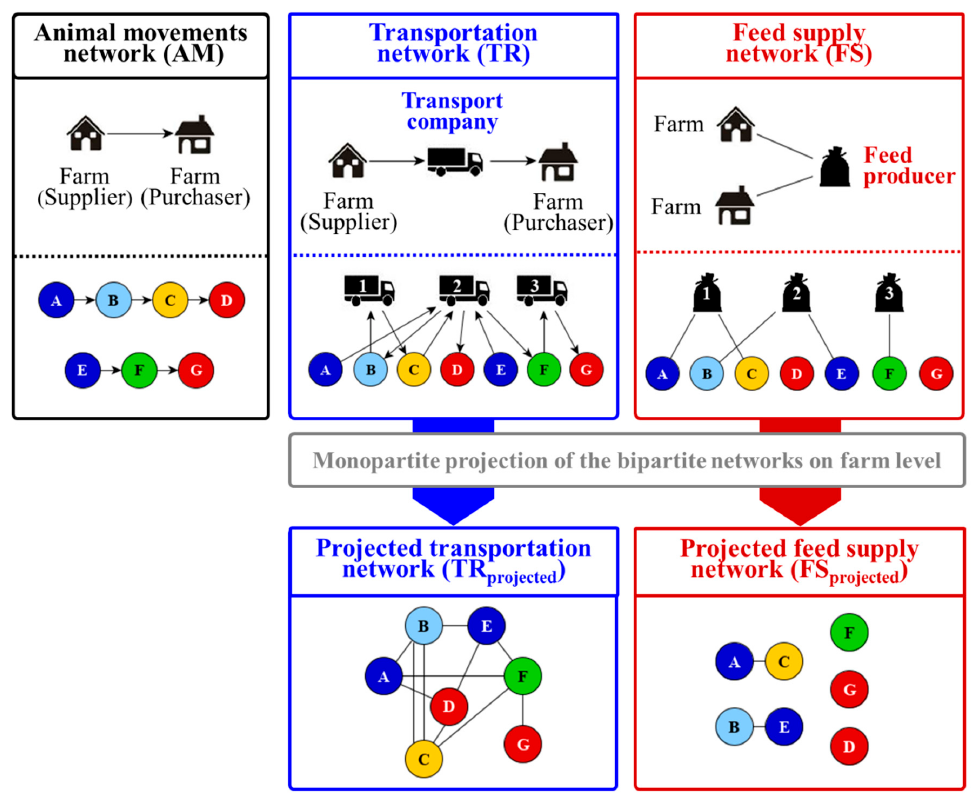
Figure 1. Network representations used in the present study. Monopartite network of animal movements between farms (black), bipartite transportation network (blue) and feed supply network (red). For both bipartite network representations, the monopartite projection on the farm level is illustrated.